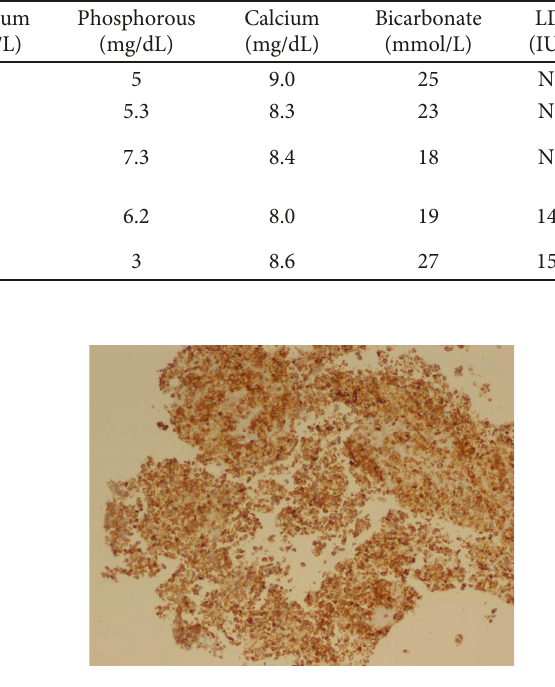
Figure 2: Pathology. High Power. H&E stain showing sheets of tumor cells with hyperchromatic nuclei and scant cytoplasm.